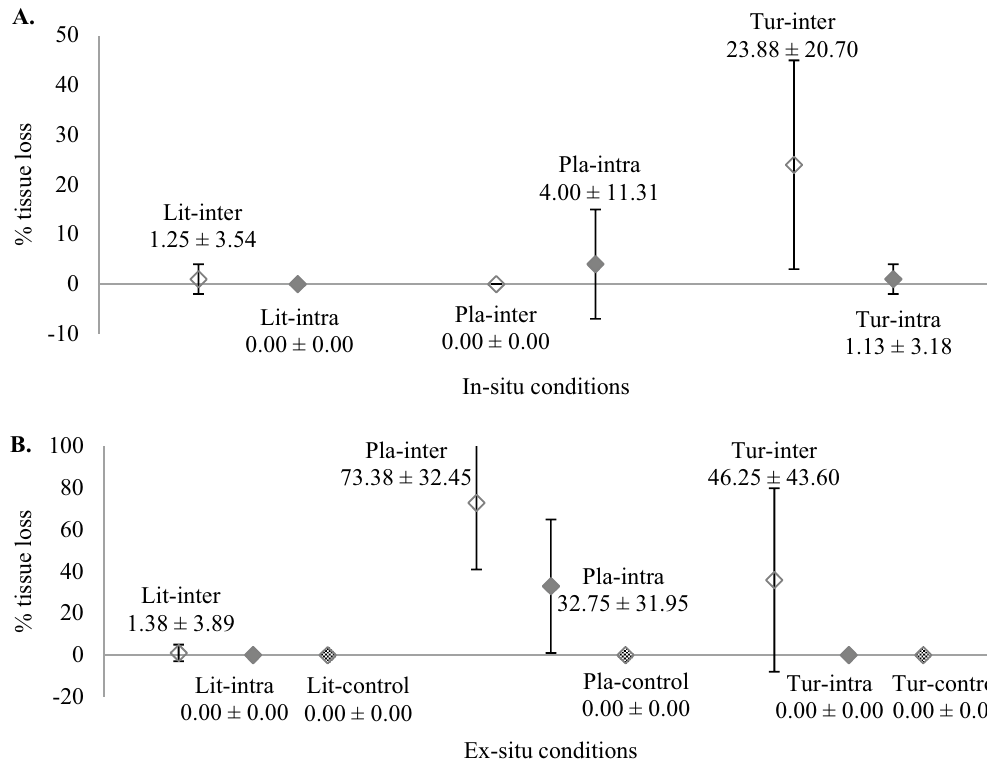
Figure 1. ( A ) Per cent tissue loss (mean ± S.D.; n = 8) of micro-colonies of three coral species after 3 months during which they were either subjected to intra- or inter-specific interactions under in-situ conditions. ( B ) Per cent tissue loss (mean ± S.D.; all treatments: n = 8 except control treatment: n = 16) of micro-colonies of three coral species after 3 months during which they were either subjected to intra- or inter-specific interactions and no interaction (control) under ex-situ conditions. Lit-inter = Lithophyllon undulatum in interspecific interaction; Lit-intra = Lithophyllon undulatum in intraspecific interaction; Lit-control = Lithophyllon undulatum without interaction; Pla-inter = Platygyra sinensis in interspecific interaction; Pla-intra = Platygyra sinensis in intraspecific interaction; Pla-control = Platygyra sinensis without interaction; Tur-inter = Turbinaria mesenterina in interspecific interaction; Tur-intra = Turbinaria mesenterina in intraspecific interaction; Tur-control = Turbinaria mesenterina without